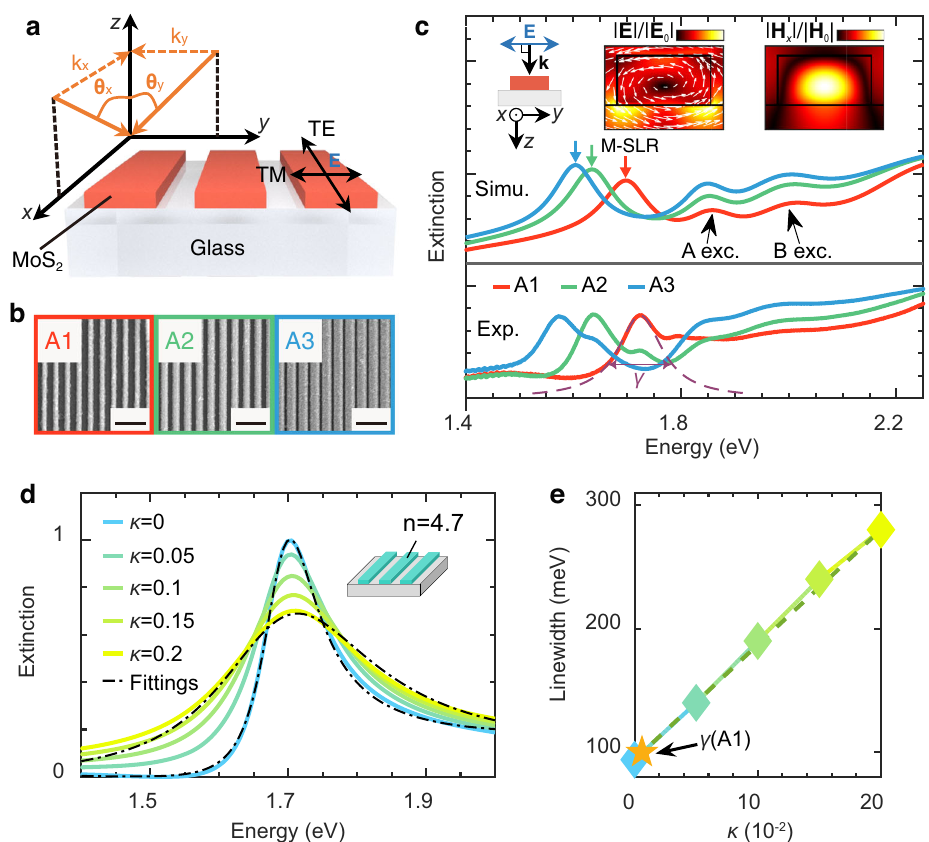
Fig. 3 | M-SLR mode of the 1D MoS 2 grating. a Schematic structure of MoS 2 grating on the glass substrate. k x and k y are in-plane components of the incident wavevector k in x - and y- directions. TM is short for transverse-magnetic polar- ization and TE is short for transverse-electric polarization. b SEM images for 1D MoS 2 gratings (A1-A3 regions). All black scale bars represent 1 μ m. c Measured (bottom)andsimulated(top)extinctionspectraunderTM-polarizedincidencefor A1-A3 regions. Red, green, and blue arrows indicate the magnetic-surface lattice resonance (M-SLR) modes of A1-A3, where the spatial distributions of the electric and magnetic ( x -component) fi elds at M-SLR are shown in the insets. The white